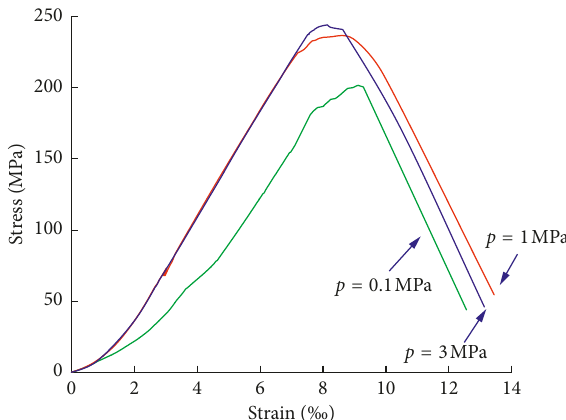
Figure 12: The axial stress-strain curve of the tested specimens under different support